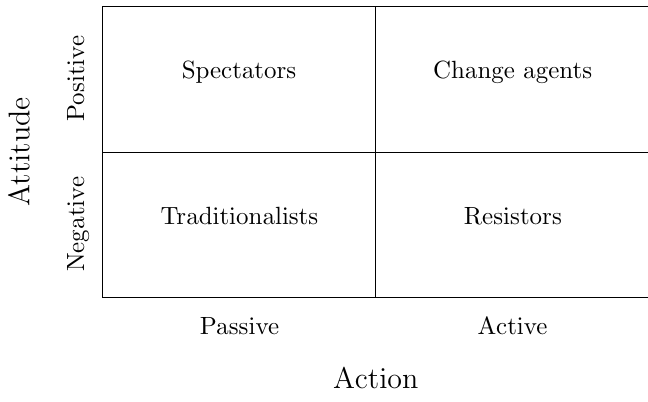
Figure 1: Types of behaviour in organisational